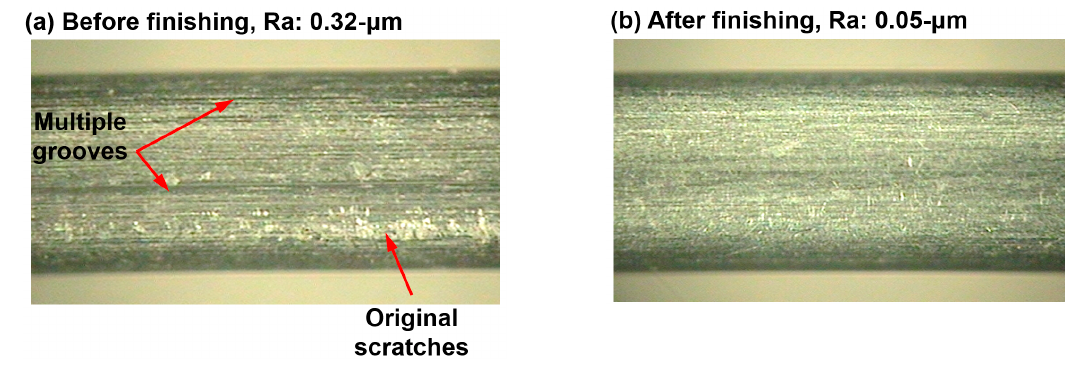
Figure 9. Micro-images of surface roughness before and after finishing: ( a ) before finishing (Ra = 0.32) and ( b ) after finishing (Ra = 0.05).